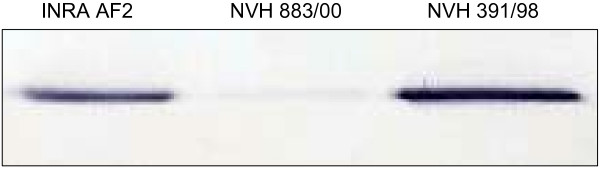
Detection of CytK in culture supernatants. Western immunoblot probed with antiserum against CytK. The samples are supernatants from B. cereus strains INRA AF2, NVH 883/00 and NVH 391/98, collected from late log phase cultures grown at 32°C.